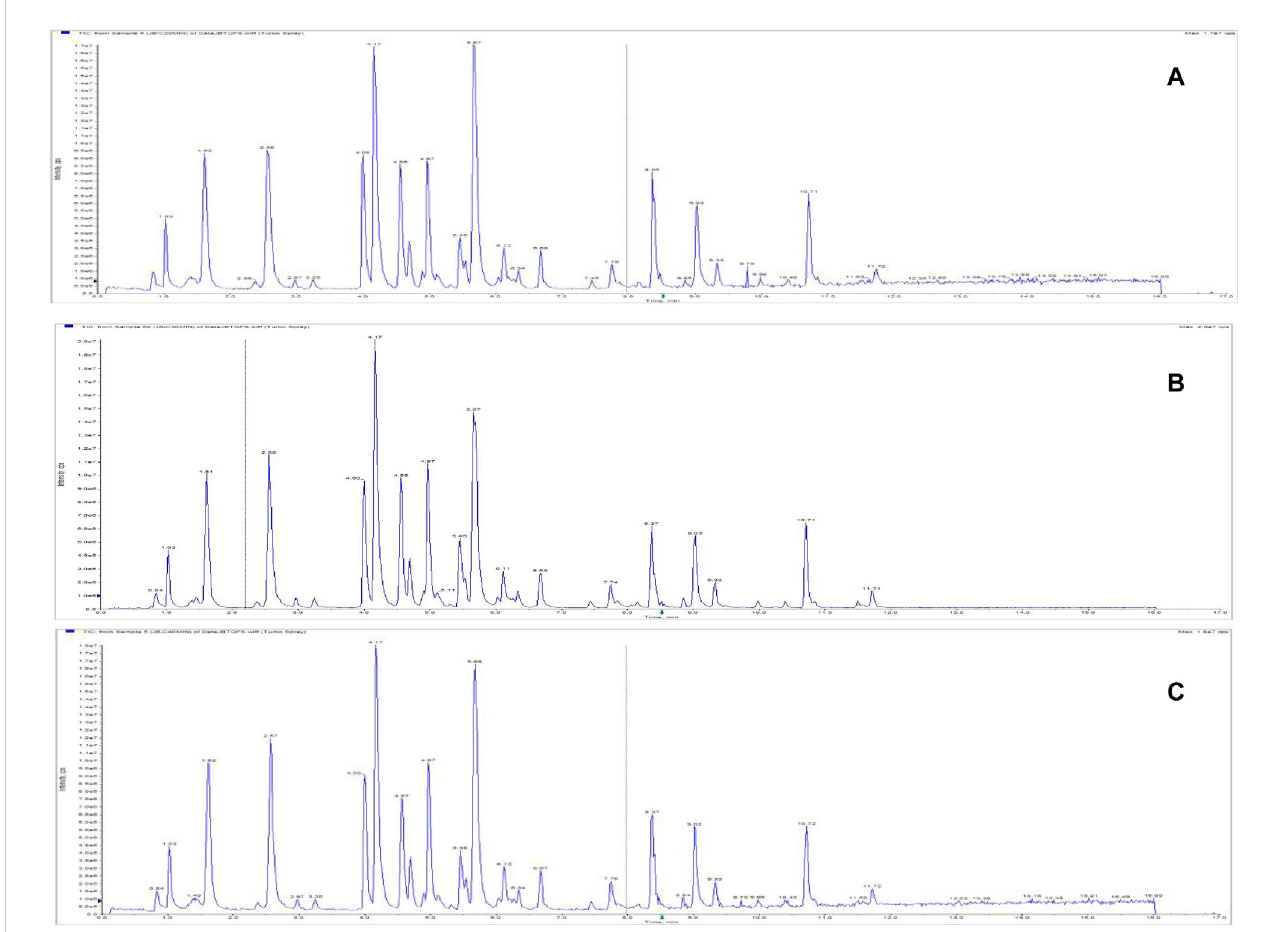
FIGURE 12 Total ion chromatograms of Jinbei oral liquid by different extraction times. (A) 20 min; (B) 30 min; (C) 40 min See Supplementary Data Sheet 4.